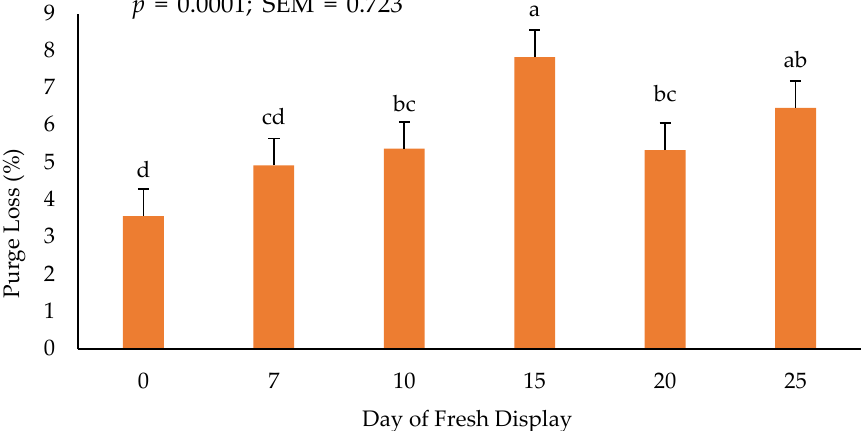
Figure 3. Influence of display day on purge loss (%) of refrigerated ribeye steaks. a–d: Bars lacking common letters differ ( p ≤ 0.05).